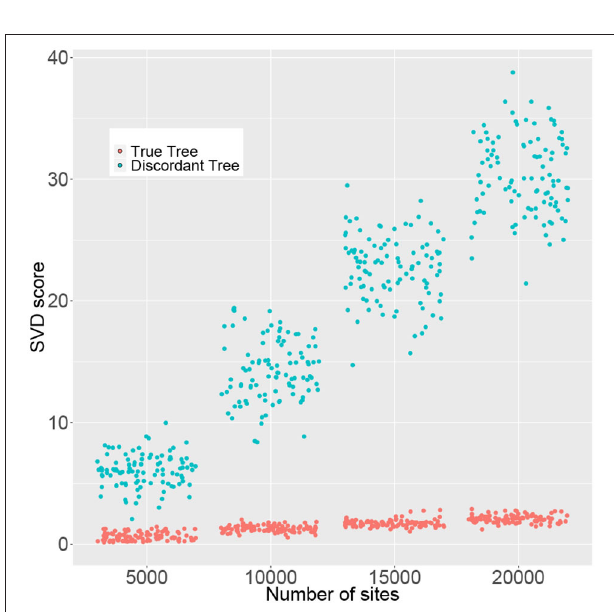
FIGURE 7 | Rank 10 SVD scores ( y -axis) for 100 replicate data sets computed for the correct tree ( T 1 , red) and a discordant tree ( T 2 , green) with varying numbers of sites ( x -axis). Points were randomly jittered on the x-axis to better display the distribution of SVD scores within each sample size.